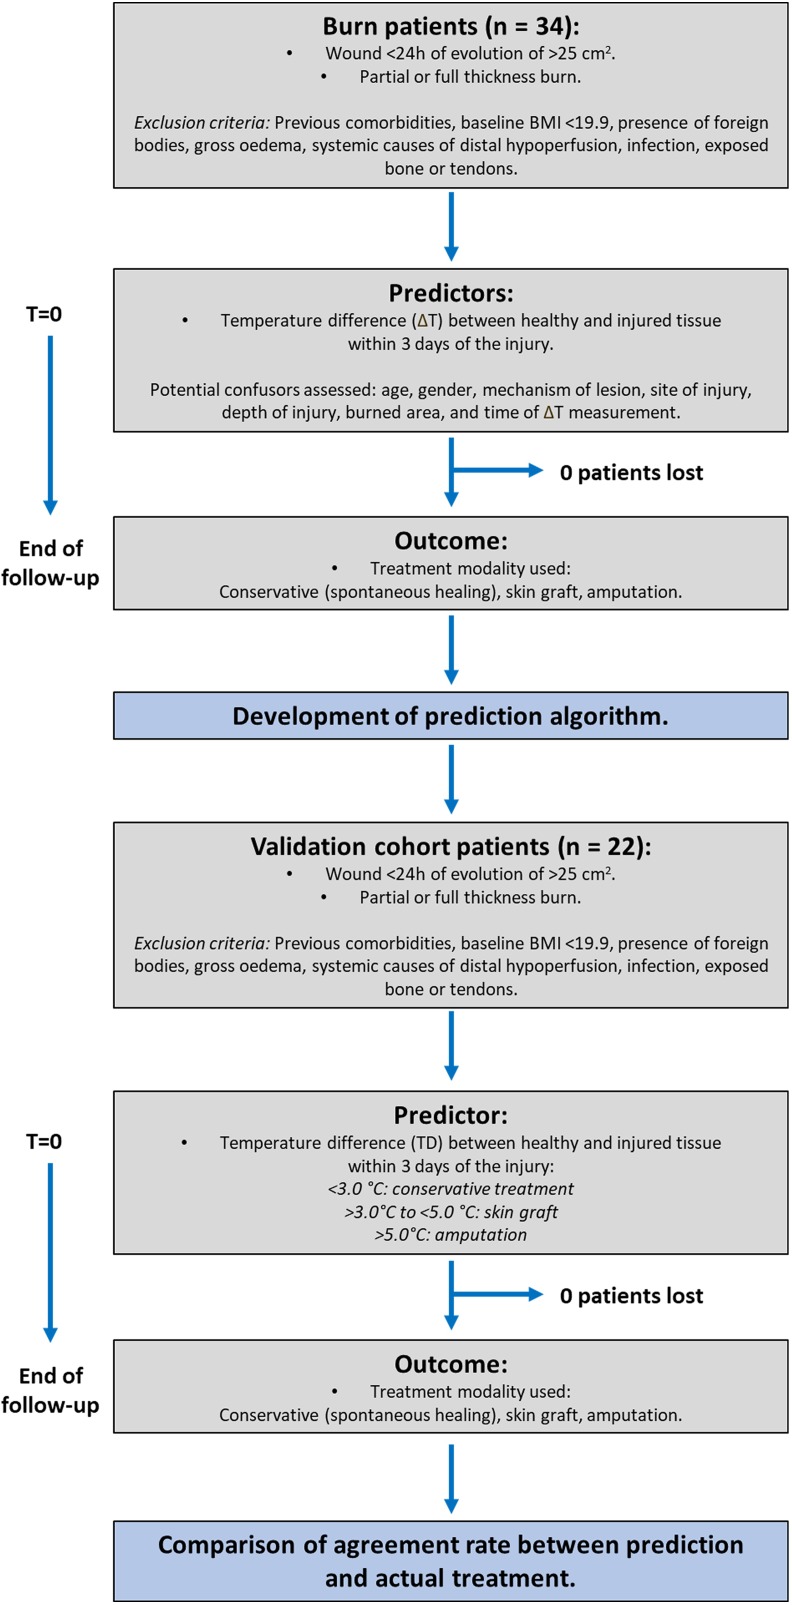
Study flowchart.